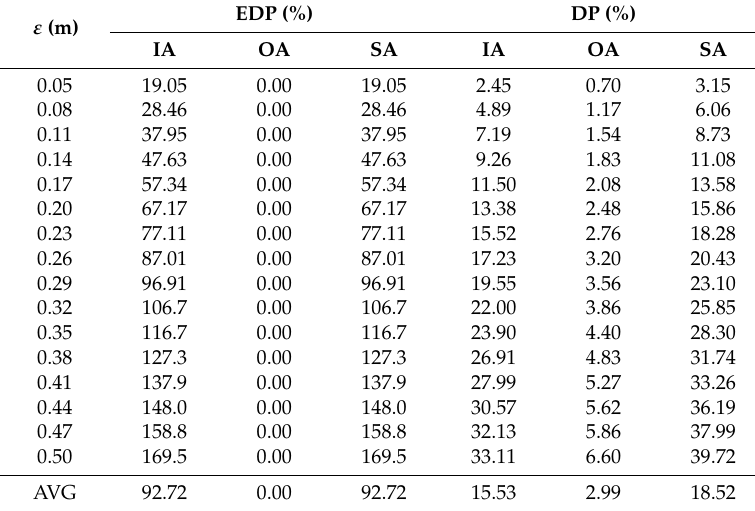
Table 1. Performance comparison between Expanded Douglas–Peucker (EDP) algorithm and Douglas–Peucker (DP) alogrithm for various ε values (The number of obstacles and vertices of each obstacle were fixed as 15, and θ rot for EDP was fixed as 30 ◦